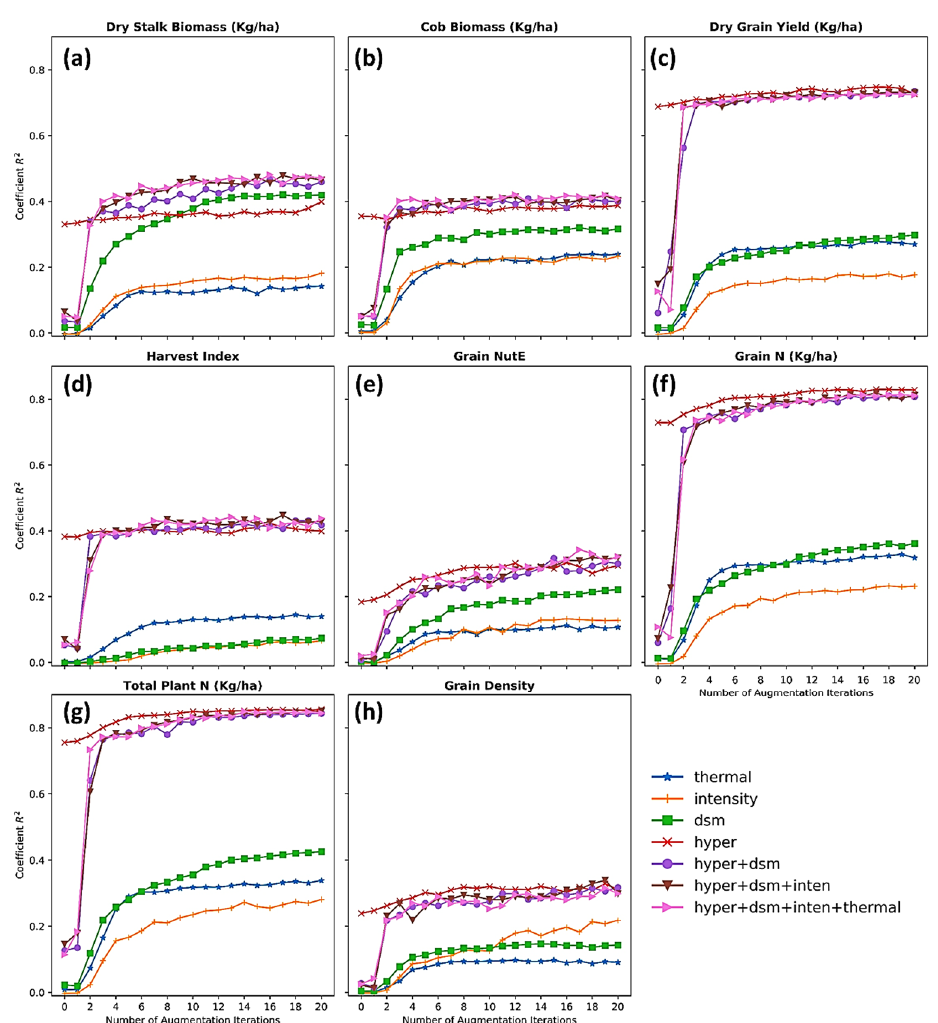
Figure 11. The effect of data augmentation on the prediction performance of multi-task deep learning with different data modality and fusions. Data types included thermal = canopy thermal images, inten = LiDAR canopy intensity images, dsm = LiDAR canopy height images, hyper = hyperspectral images. Feature fusions included hyper + dsm = a fusion of hyperspectral and LiDAR canopy height images, hyper + dsm + inten = a fusion of hyperspectral, LiDAR canopy height, and LiDAR canopy intensity images, and hyper + dsm + thermal = a fusion of hyperspectral, LiDAR canopy height, LiDAR canopy intensity, and thermal